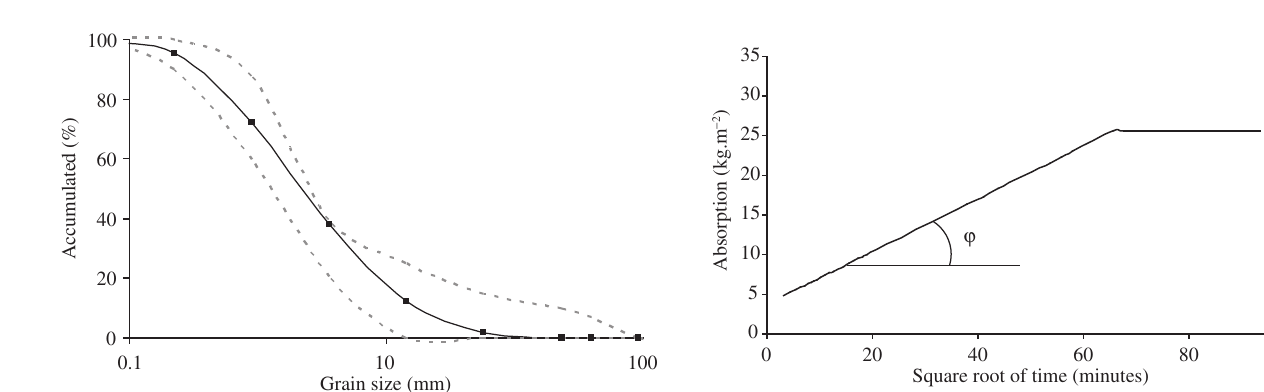
Figure 3. Particle size distribution of the sand used in the tests, which was classified as “fine sand”, according to NBR 7211 standard.